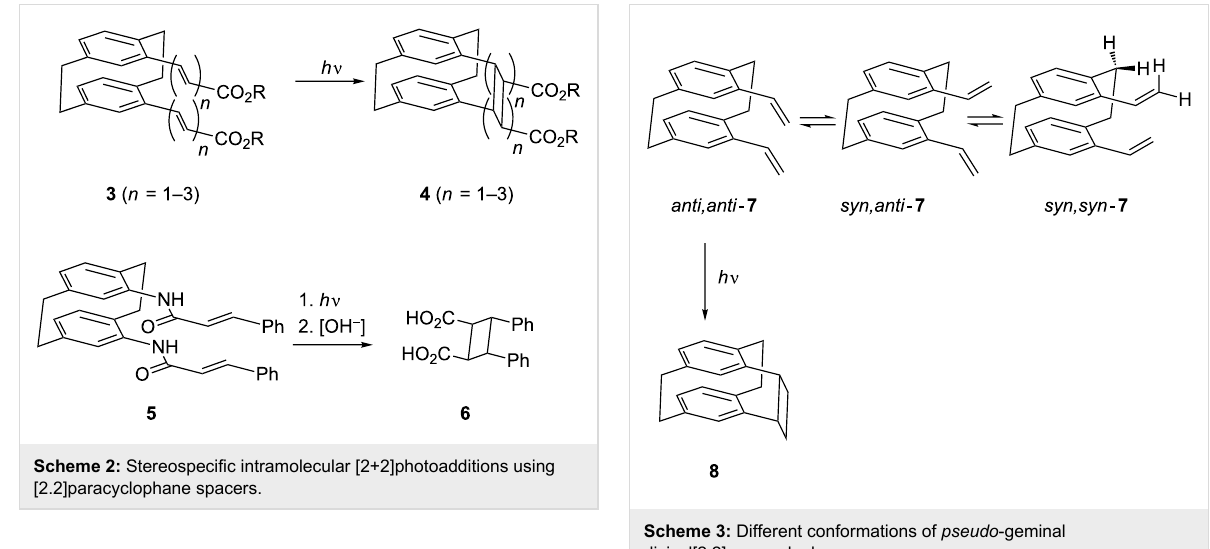
conformation ( anti referring to the orientation of the